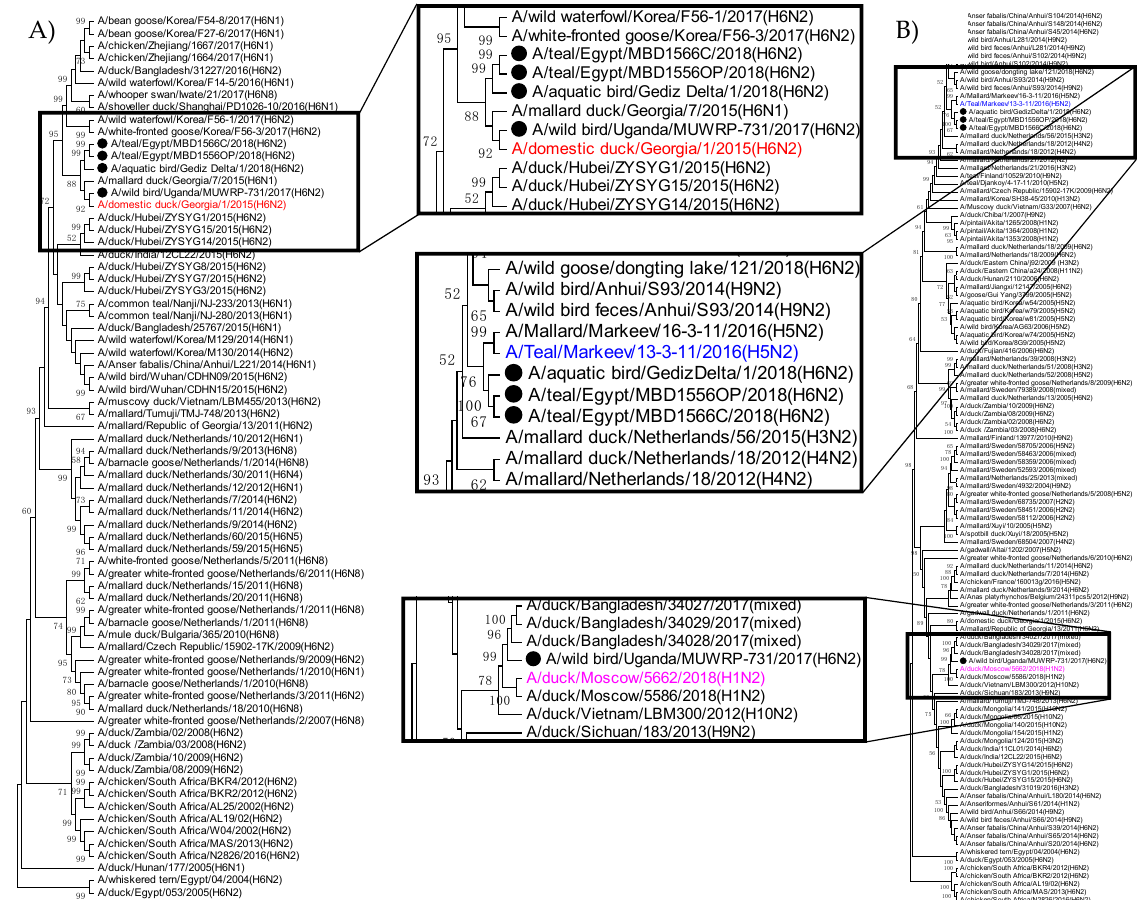
Figure 3. Phylogenetic relationships between GD/18, EG/1566C, EG/1556OP, and UG/731 based on ( A ) HA and ( B ) NA genes. All four viruses were indicated with black circles. Phylogenetic trees were constructed using the Maximum Likelihood method based on the Hasegawa-Kishino-Yano model. Phylogenetic analysis of HA gene showed that all four viruses were clustered together with A/domestic duck/Georgia/1/2015 (H6N2) strain (red). NA gene of GD/18, EG/1566C and EG/1556OP were clustered with A/Teal/Markeev/13-3-11/2016 (H5N2) (blue). UG/731 was closely related to N2 viruses from Bangladesh, Moscow and Vietnam including A/duck/Moscow/5662/2018 (H1N2) (purple).